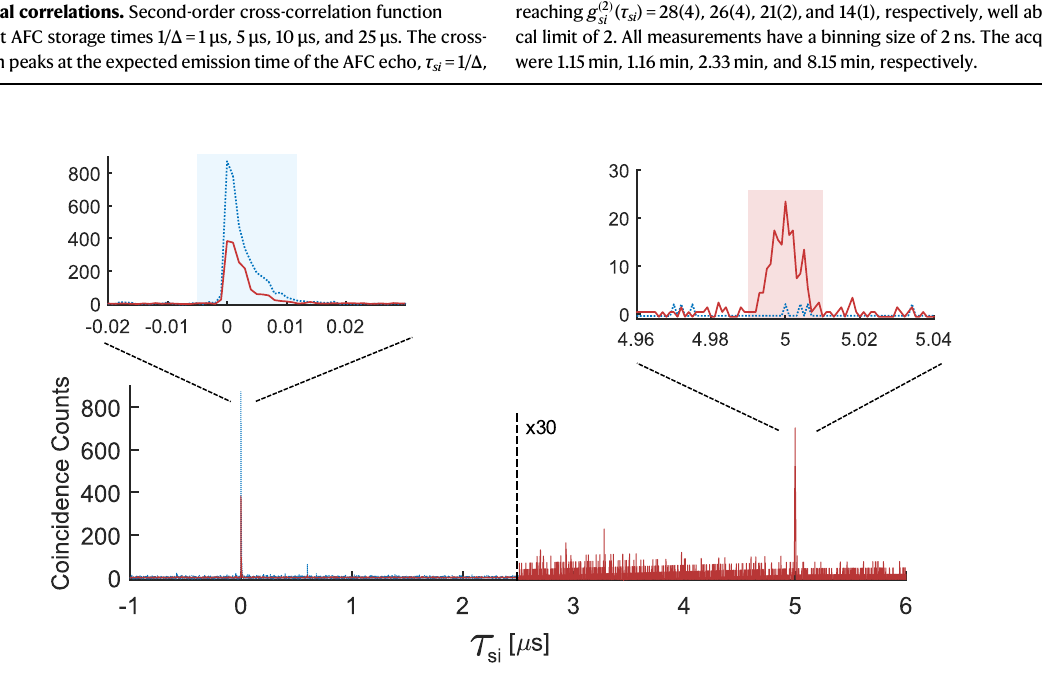
Fig. 3 | Memory ef fi ciency measurement. Two-photon coincidence detection histograms for anAFCstorage experiment with 1/ Δ =5 μ s (red solid line), and for a reference measurement through a transparency window burned into the memory